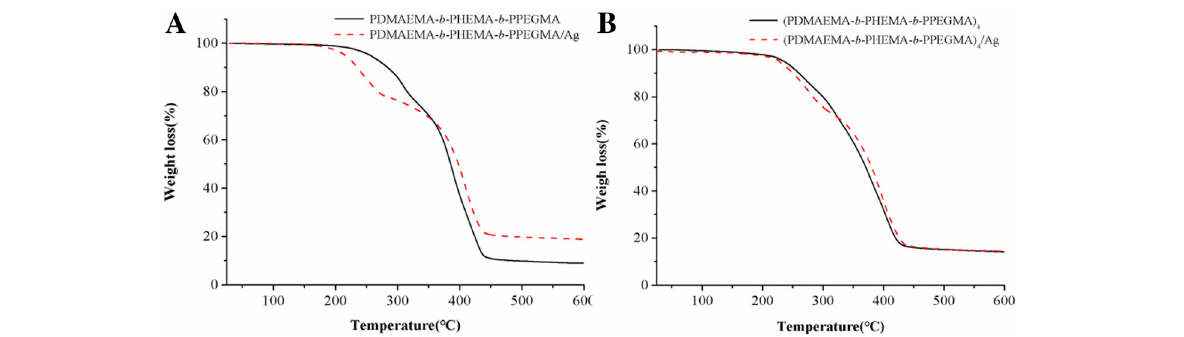
Fig. 6 TGA curves of a linear copolymers and b star copolymers micelles and their micelles stabilized AgNPs at PDMAEMA/AgNO 3 molar ratio = 6/1